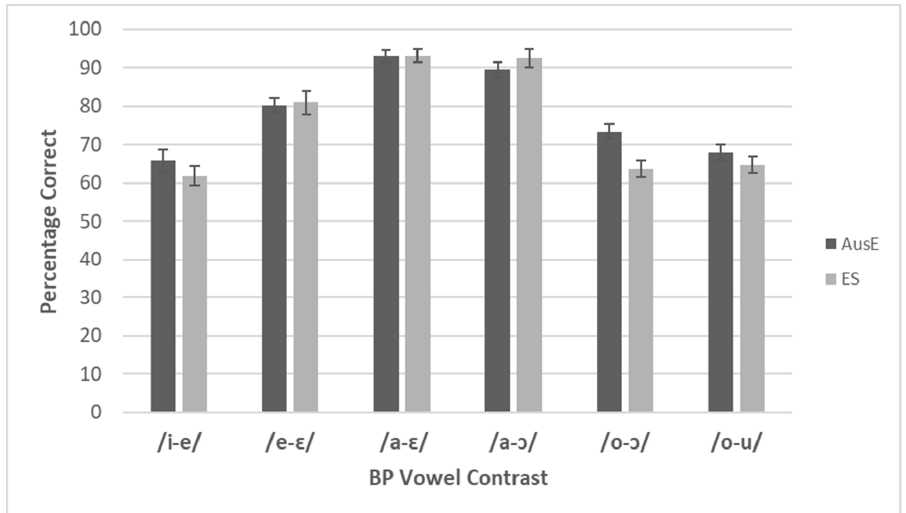
Figure 3. Overall discrimination accuracy including variability for AusE and ES.